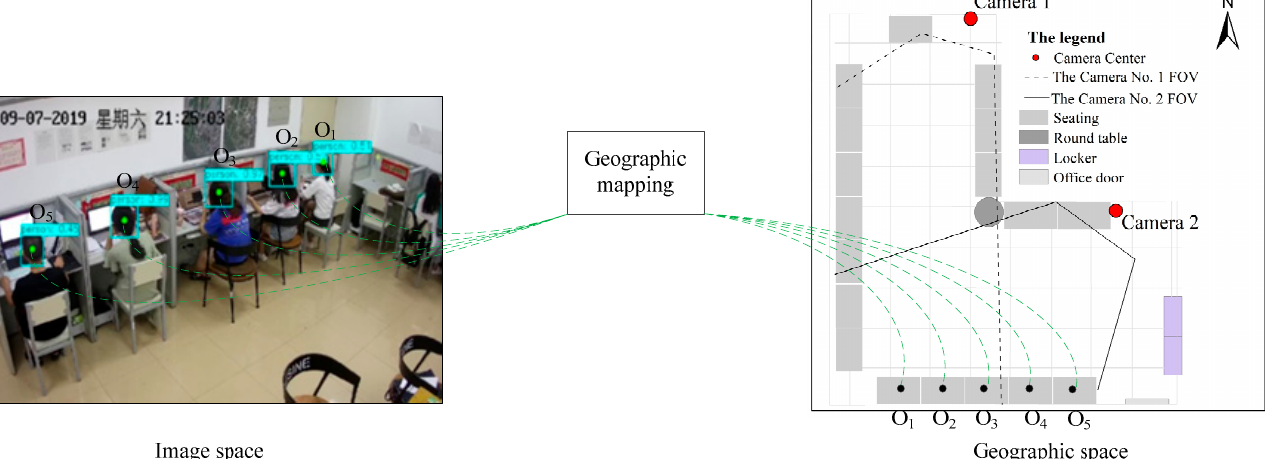
Figure 3. Object detection and geographic mapping.